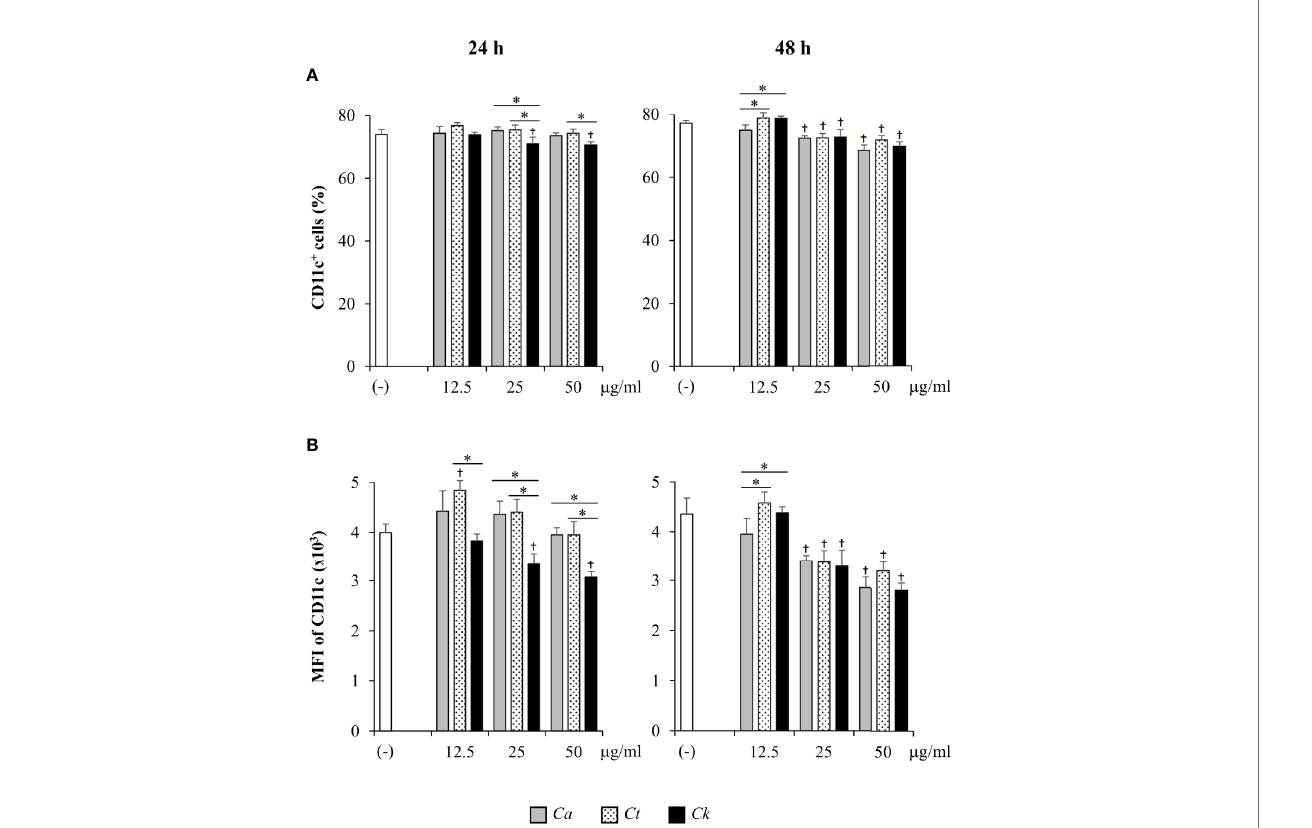
FIGURE 3 | Determination of CD11c + cell proportion and CD11c expression in bone-marrow derived dendritic cells (BMDCs) stimulated with Candida b -glucans. BMDCs were stimulated with 12.5, 25, and 50 µg/ml of b -glucans isolated from C. albicans , C. tropicalis , and C. krusei for 24 h and 48 h. Cells were analyzed by fl ow cytometry. (A) The percentages of CD11c + cells were assessed using a dot pot analysis. (B) The geometric mean fl uorescence intensity (MFI) of CD11c was determined using a histogram analysis. n = 5; data are representative of two independent experiments. † p < 0.05 compared with unstimulated BMDCs, * p < 0.05. (-), unstimulated BMDCs; Ca , C. albicans ; Ct , C. tropicalis ; Ck , C. krusei